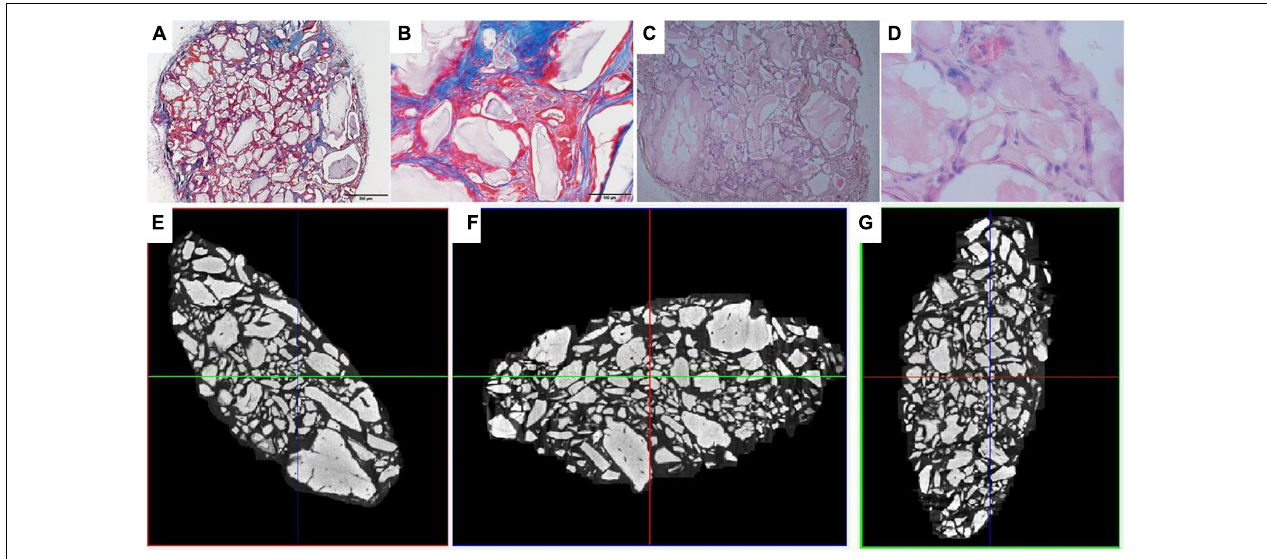
FIGURE 13 | Visualization of explant donor 2 spinner flask1 results. (A,B) Masson’s Trichrome staining. (C,D) H&E staining. (E–G) nanoCT scans 2D sections in all 3 planes.